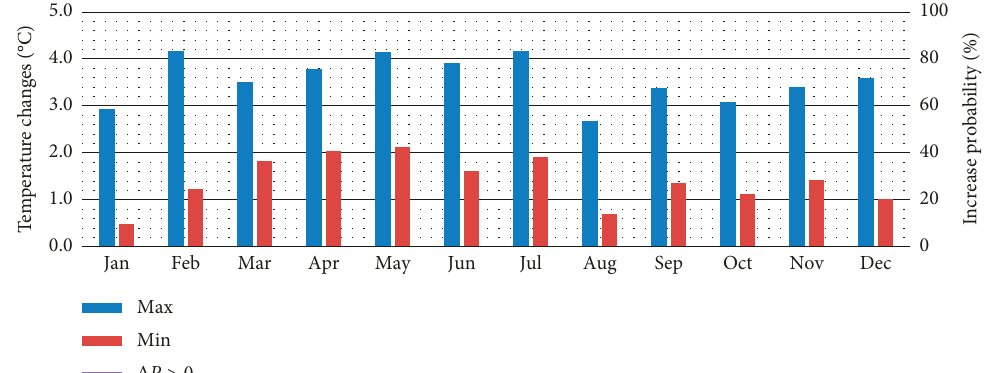
Figure 10: Range of changes in the monthly average of the maximum daily temperature in the future middle period under all the models and three emission scenarios and their